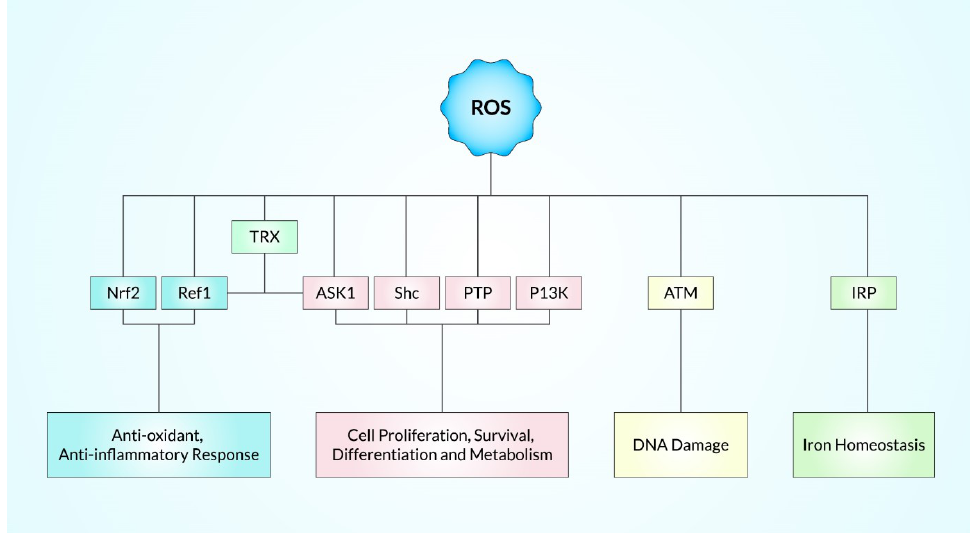
Figure 2. Both exogenous as well as endogenous regulatory sources of ROS along with enzymatic, and nonenzymatic antioxidants. In addition, the aggregation of excessive production of ROS can be toxic, but specific amounts of ROS are required for an effective signaling process. It is critical for cells to maintain strict control over their mitochondrial ROS (mROS) levels [87]. Antioxidant scav- enging proteins also take part in a significant role in regulating the formation of mROS within cellular compartments. The formation of mROS is poorly understood in vivo, hence research on isolated mitochondria and cells in vitro has provided valuable insight into its regulation [88]. Numerous factors have been discovered to influence mROS for- mation, including the amount of intracellular O 2 level, the frequency of electron delivery to the electron transport chain (ETC), the concentrations of a specific electron transport system, and the REDOX level within the ETC [89]. mROS is regulated by the mitochon- drial membrane potential (MMP), which is a chemical and electrical gradient that forms across the mitochondrial inner membrane as protons are pushed into the inter-membrane region by different subunits such as I/II/III/IV of the ETC. The presence of enhanced MMP has been linked to a rise in mitochondrial ROS [90]. Also of note, loss of mROS is associ- ated with a reduction in mROS production, which may be recovered with the restoration of MMP, demonstrating that it is both essential and sufficient for mROS formation [91].